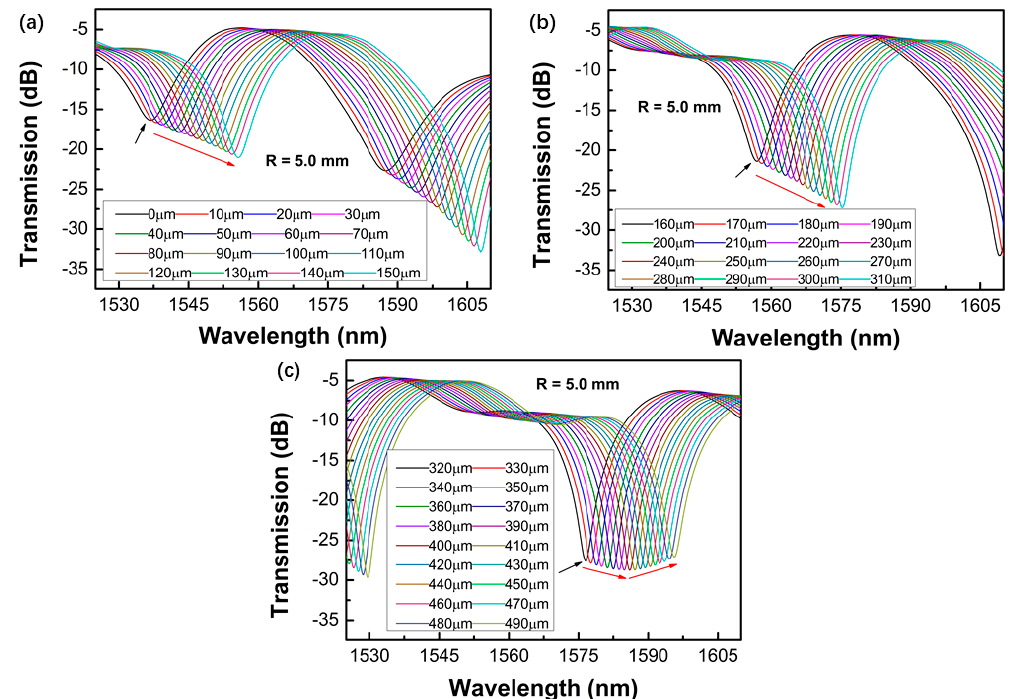
Figure 7. Transmission spectra of the proposed sensors varied with the displacement ranges of 0–150 µ m ( a ), 160–310 µ m ( b ), and 320–490 µ m ( c ) for the bending radius of 5.0 mm.